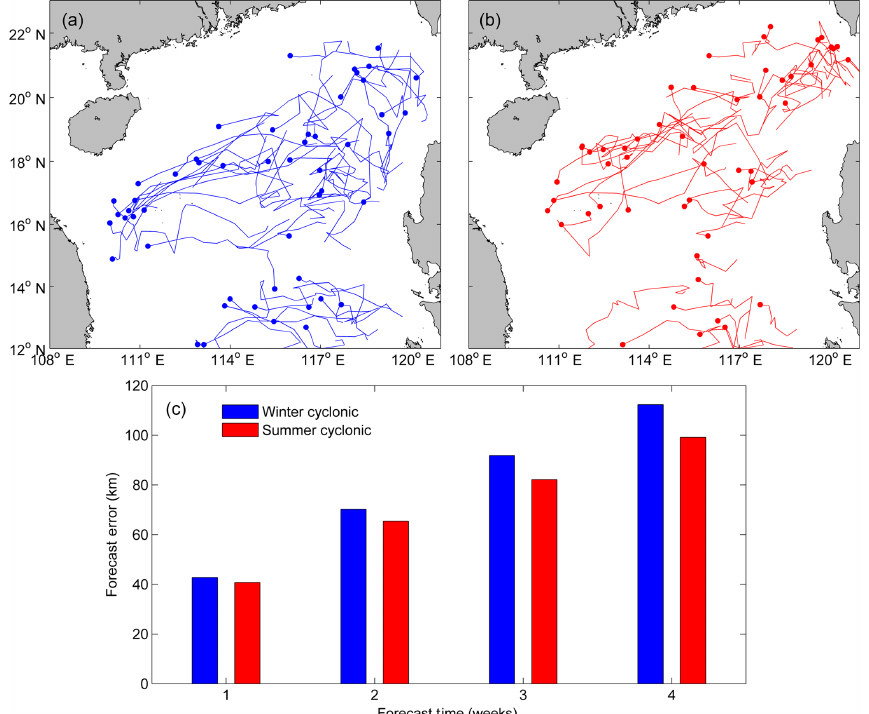
Figure 8. The same as Fig. 7, but for the cyclonic